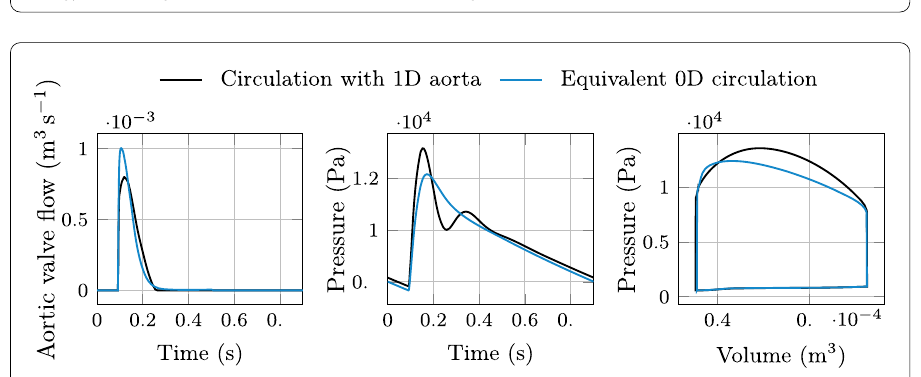
Fig. 10 The important role of the one-dimensional aortic model as a boundary condition for the reduced cardiac model is highlighted comparing the output of the uncoupledcardiacmodel (blue line) and the fully coupledmodel (black line) settings, with a focus on the presence of the dicrotic notch in the aortic pressure curve. From left to right we depict the blood flow coming from the aortic valve, the aortic pressure ( P ar ) and the pressure-volume loops in the left